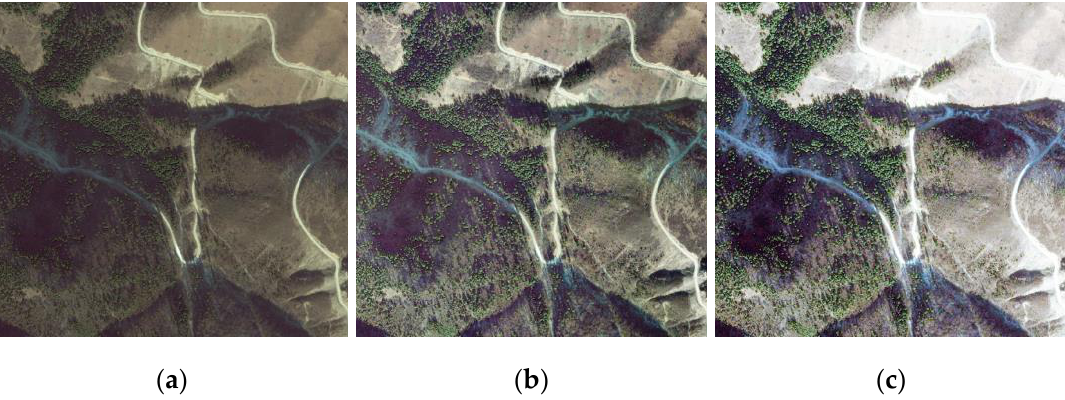
Figure 2. Diagram of image preprocessing: ( a ) Original image; ( b ) image processed by contrast limited adaptive histogram equalization (CLAHE) and ( c ) image processed by histogram equalization (HE).